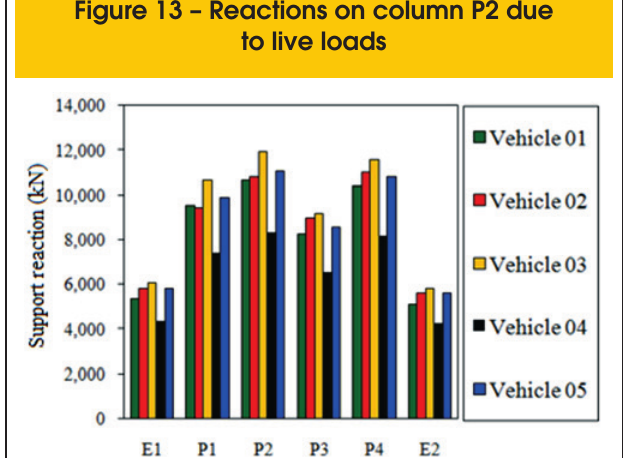
Figure 13 – Reactions on column P2 due to live